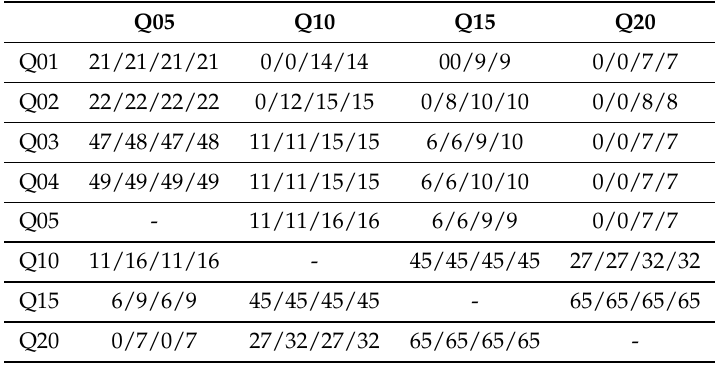
Table 12. Test results for similar Word documents with SiSe, part 2 (hash vs. hash/file vs. hash/hash vs. file/file vs.